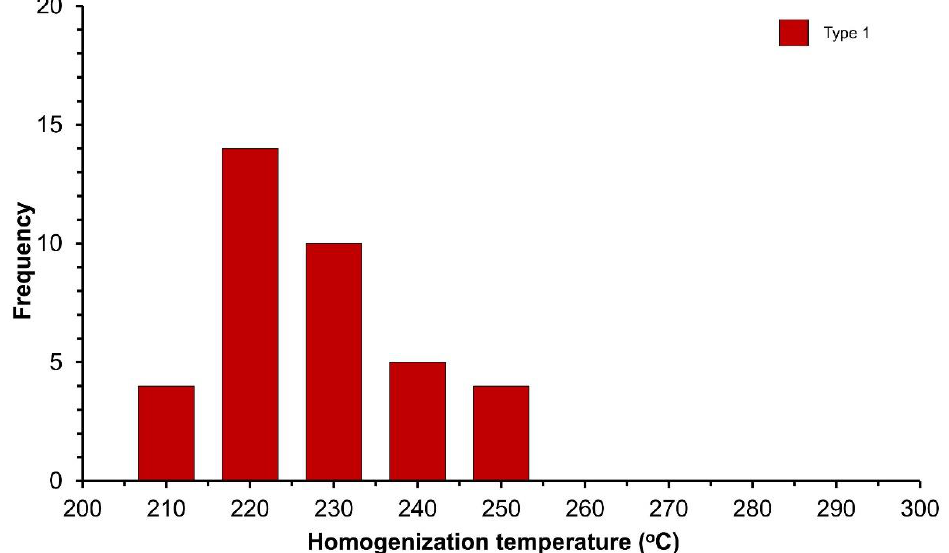
Figure 14. Histogram showing the homogenization temperatures of Type 1 fluid inclusions in quartz from the stibnite Rizana mineralization.